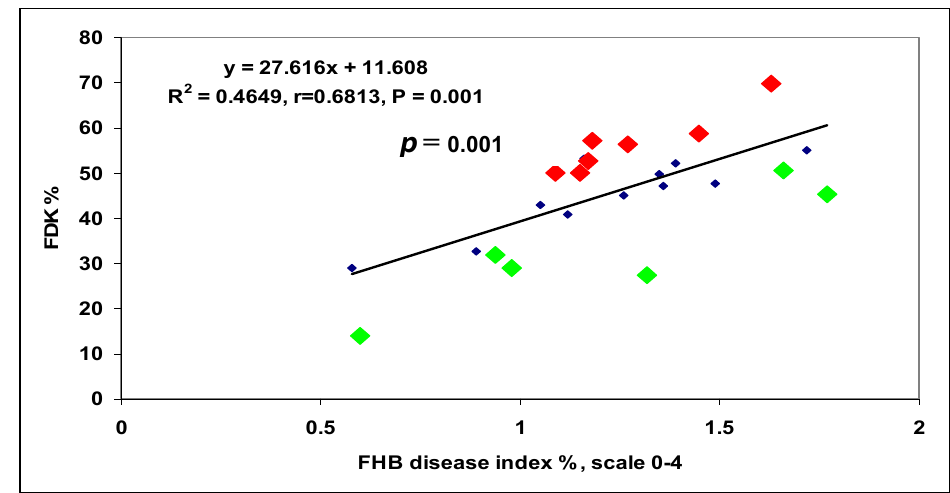
Figure 10. FDK overproduction and resistance in FHB resistance tests in winter wheat genotypes against two F. graminearum and two F. culmorum strains, 1983–1988. Red data points: FDK overproduction, data from the regression line are farer than the LSD 5% 4.49 to the larger DON concentrations; green data: resistance to kernel infection, data from the regression line are farer than the LSD 5% 4.49 to the lower DON concentrations. LSD 5% for FDK is 4.49 [3].